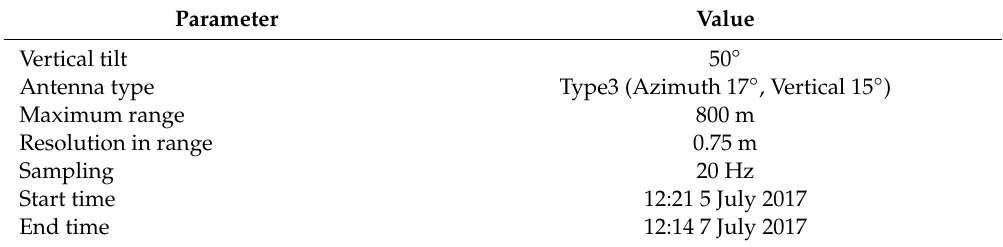
Figure 5. Location of the IBIS-S-2 system in the east–west direction. ( a ) View of the IBIS-S-2 interferometric radar on S2 (located in the Wuchang River Beach Park). ( b ) Ground view of the WGC from the location of the IBIS-S-2 interferometric radar. Table 1. Configuration of IBIS-S systems for the measurement